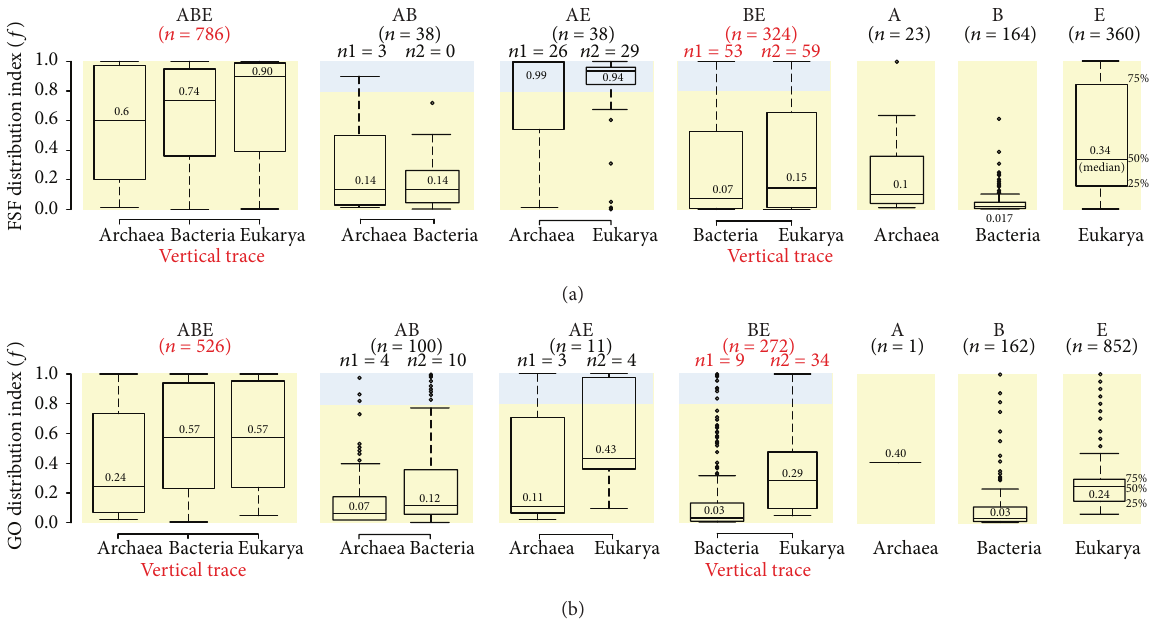
Figure 3: The spread of FSF domain structures (a) and GO terminal terms (b) in the proteomes and functionomes of each member of the superkingdom in the seven Venn taxonomic groups (panels ABE, AB, AE, BE, A, B, and E). Shaded regions indicate that FSFs or GOs were present in > 80% of the proteomes ( 𝑓 > 0.8 ), and their numbers, 𝑛 1 and 𝑛 2 . Numbers in boxplots of each distribution indicate group medians. Numbers in red suggest the strongest vertical evolutionary trace. Table 1: List of universal FSFs that were present in all proteomes of the structure dataset.